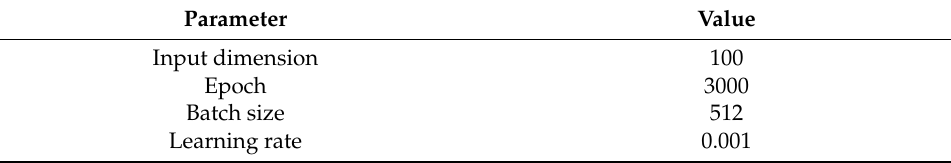
Table 1. Training parameters of